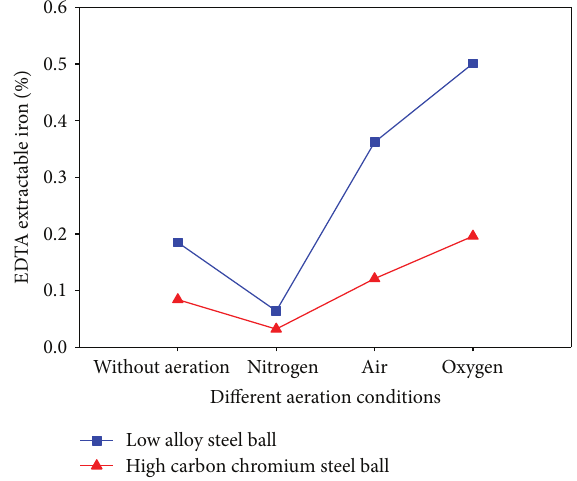
Figure 5: EDTA extractable iron in the mill discharge under different aeration conditions for two types of grinding